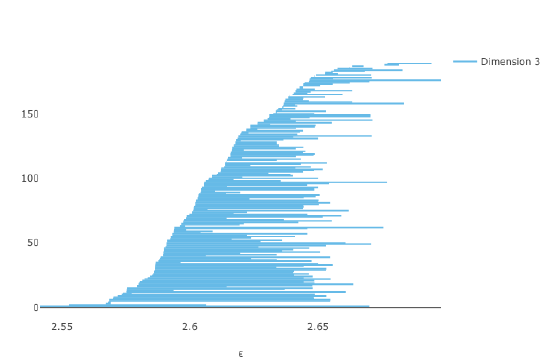
Figure 8. The H 3 barcode for 100 points on R P 3 .